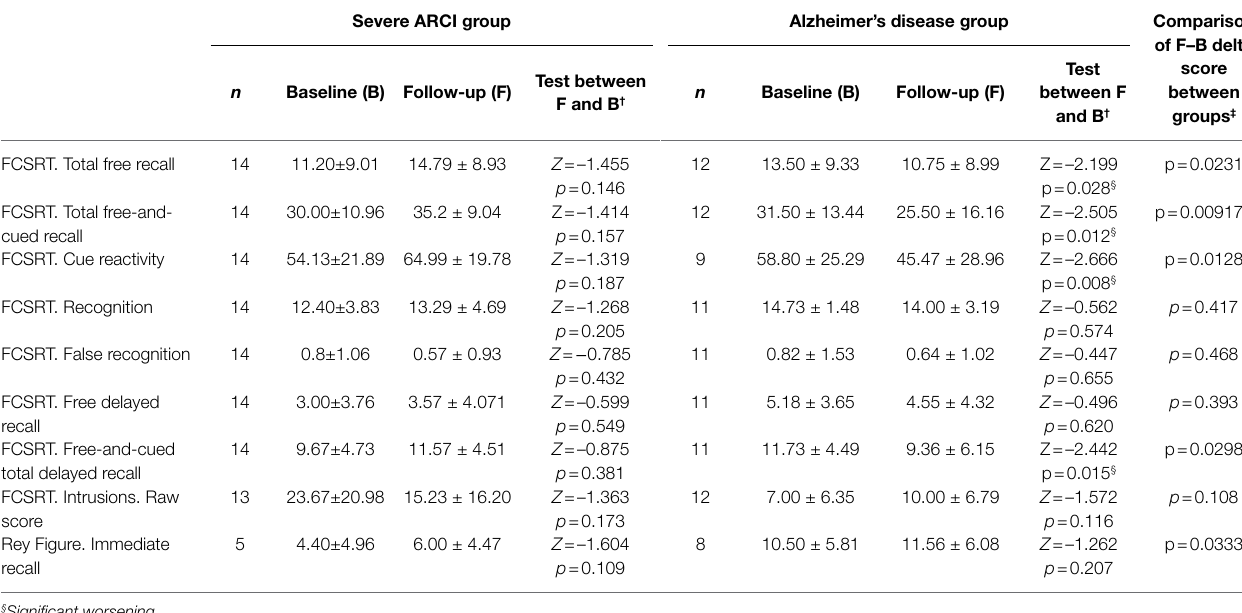
TABLE 4 | Results of cognitive tests of memory at baseline (B) and follow-up (F) in severe Alcohol-Related Cognitive Impairment (severe ARCI) group ( n = 15) and in Alzheimer’s disease group ( n = 12).